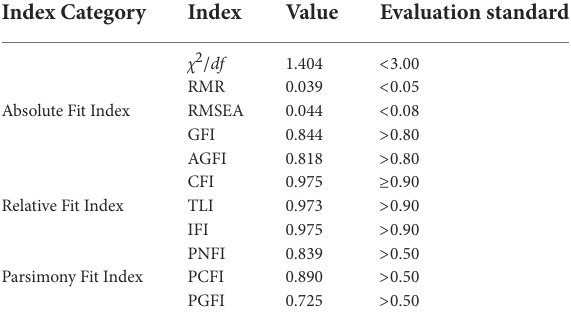
TABLE 5 The fit evaluation results of the